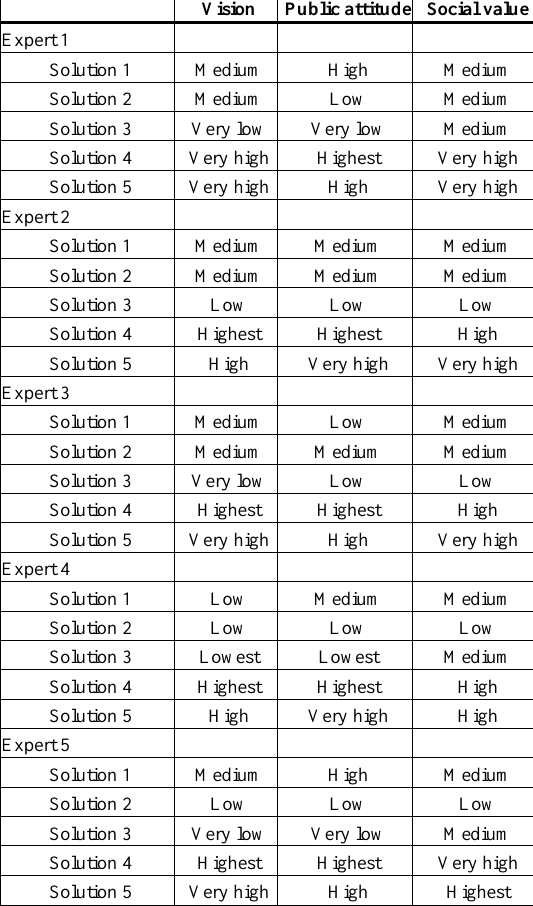
Table 7. The relevance degrees of solutions